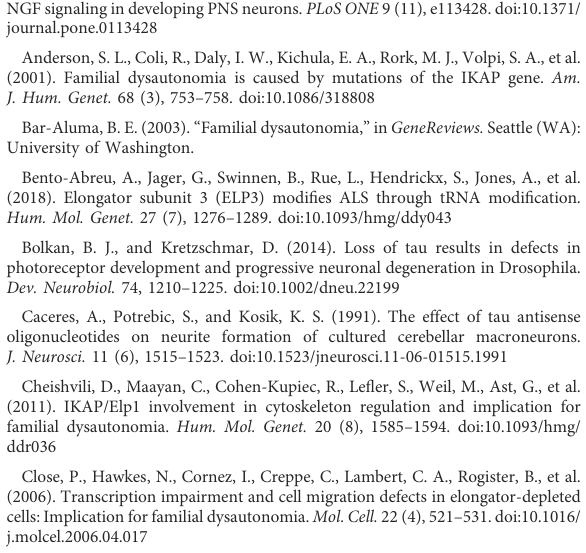
SUPPLEMENTARY FIGURE 1 Elongator depletion leads to reduction in Tau protein expression (A,B) Western blotting to detect and quantify Tau, and ß-Actin in cortical extracts from newborn WT and Elp3 cKO mice. (B) Histogram of proportion of Tau expression to ß-Actin. (C,D) Western blotting to detect and quantify Tau, and ß-Actin in adult fl y head extracts following neuronal (elav-driven) expression of wt and Elp3 KD. (D) Histogram of proportion ofTauexpressiontoß-Actin.All graphs show values ofmeans ±SEM.Signi fi cancewasdeterminedby:b,dtwo-sidedttest,Speci fi cally, [ (B) p = 0.0161; (D) p = 0.0216; (B) n = Number of mice: Control n = 4; Elp3 cKO n = 4; (D) n = Number of experimental repeats: Control n = 5; Elp3 KD n = 5. SUPPLEMENTARY FIGURE 2 Tau is hypoacetylated, a result of impaired production of acetyl-CoA upon Elongator depletion. (A) Western blotting to detect and quantify acetylated alpha tubulin, and ß-Actin in differentiated SHSY5Y extracts from Control and Elp1 KD cells. Histogram of proportion of acetylated alpha tubulin expression to ß-Actin. (B) In vitro acetylation assay of non- acetylated MTs from HeLa cells incubated for 2 hours with extracts of differentiatedSHSY5YControlandElp1KDcells.Allgraphsshowvaluesof means ± SEM. Signi fi cance was determined by: b two-sided t test, Speci fi cally, [p = 0.0106] (D) one-way analysis of variance